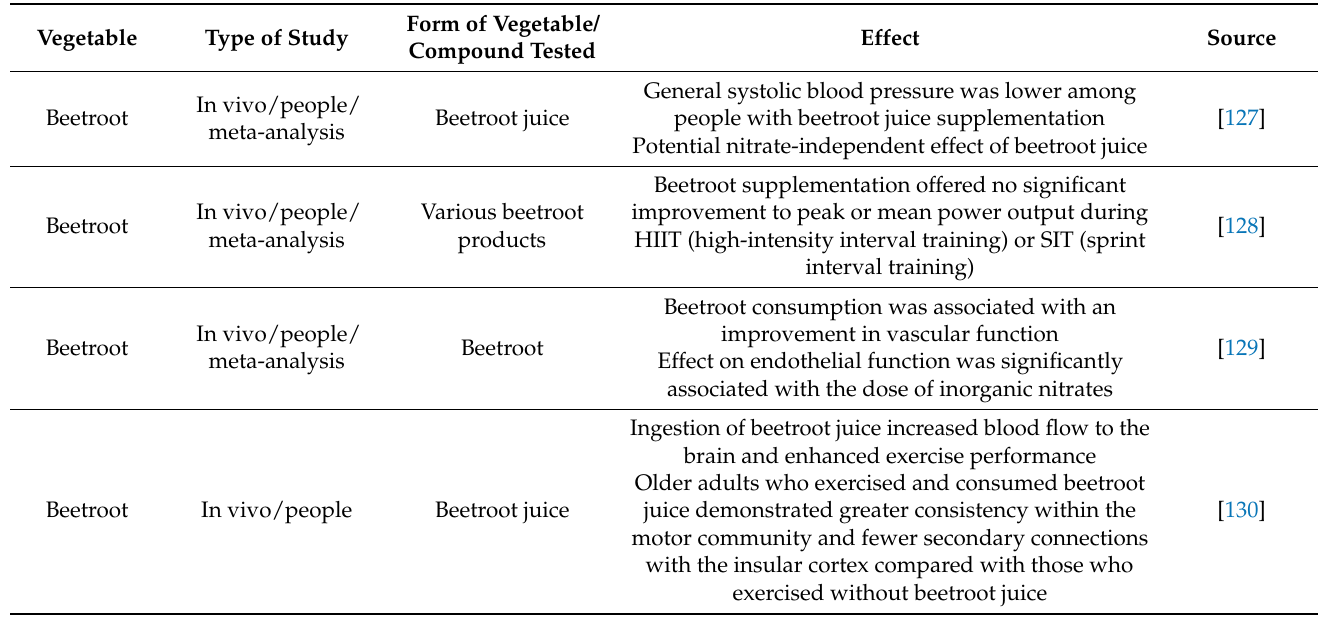
Table 5. Influence of root vegetables from the botanical order Amaranthaceae on